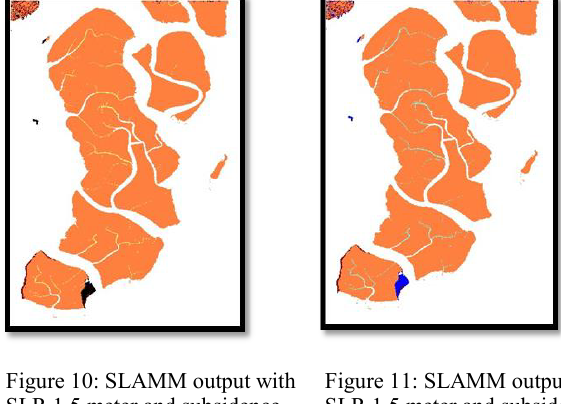
Figure 10: SLAMM output with Figure 11: SLAMM output with and subsidence SLR 1.5 meter SLR 1.5 meter and subsidence